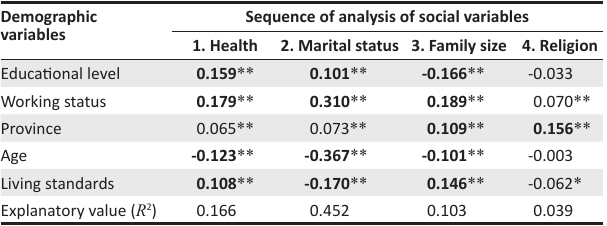
TABLE 5: Results of the sequential analysis illustrating the relationship between the various underlying demographic and social variables. Demographic variables